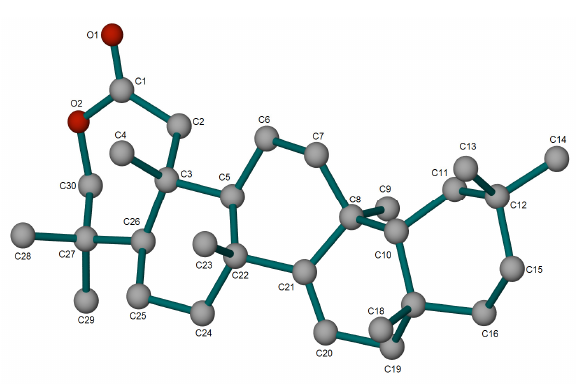
Figure 2. ORTEP diagram for 4 .